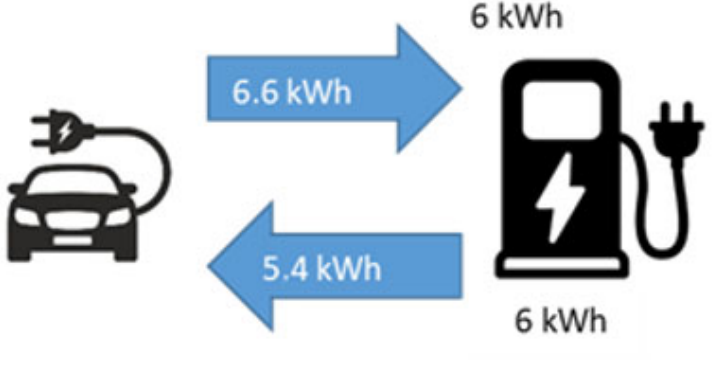
Figure 8. Abuse of efficiency in both directions.